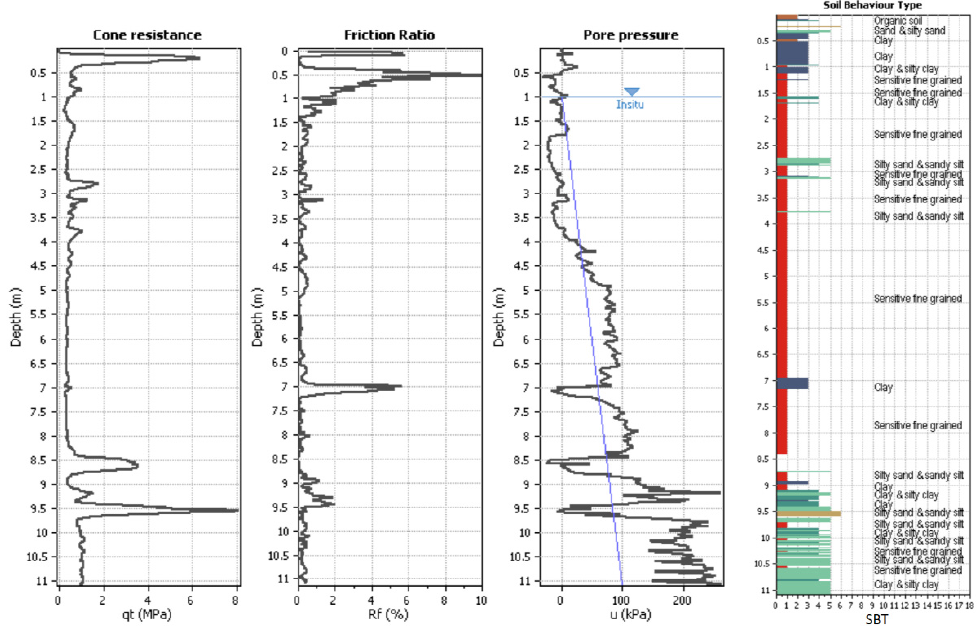
Figure 17. CPT characterization and SBT plot for Site 4 (after Anderson [40]).